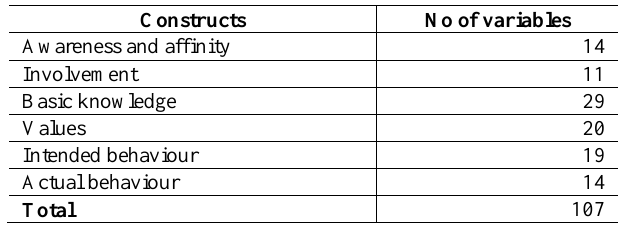
Table 1: Research constructs and variables